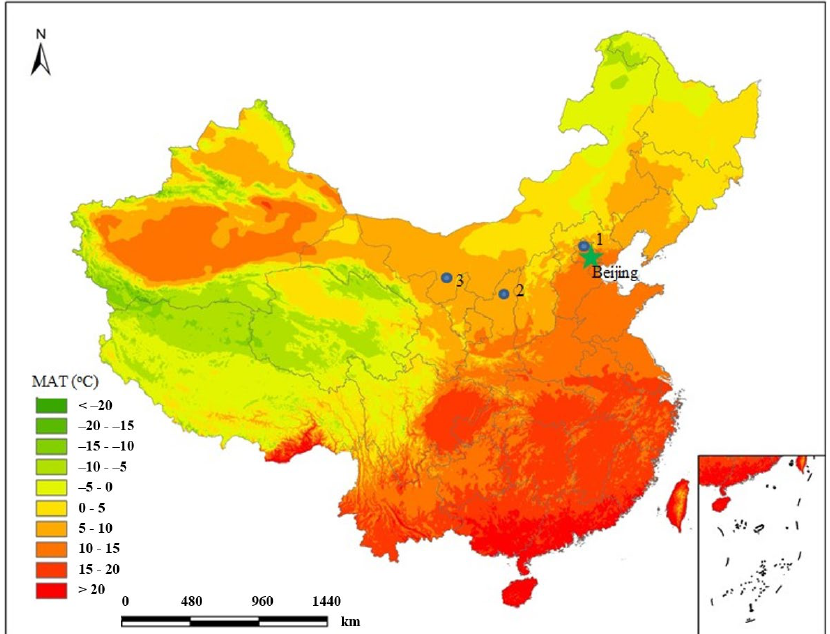
Figure 9. Plant sampling sites. Sampling sites are indicated with solid circles and numbers, 1, Bai- wangshan Mountain, northern China; 2, Luochuan, northwestern China; 3, Shapotou, northwestern China. MAT is the mean annual temperature of the past 50